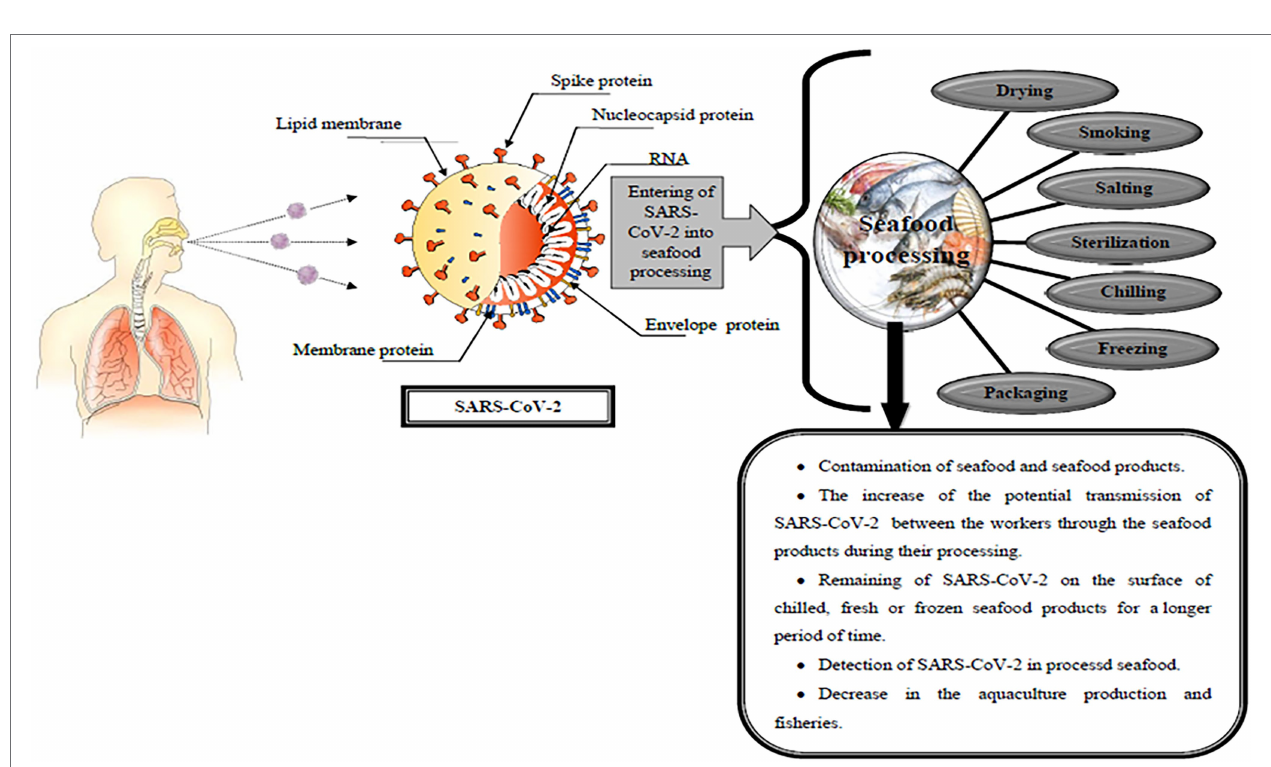
FIGURE 2 | The impacts of SARS-CoV-2 on seafood processing